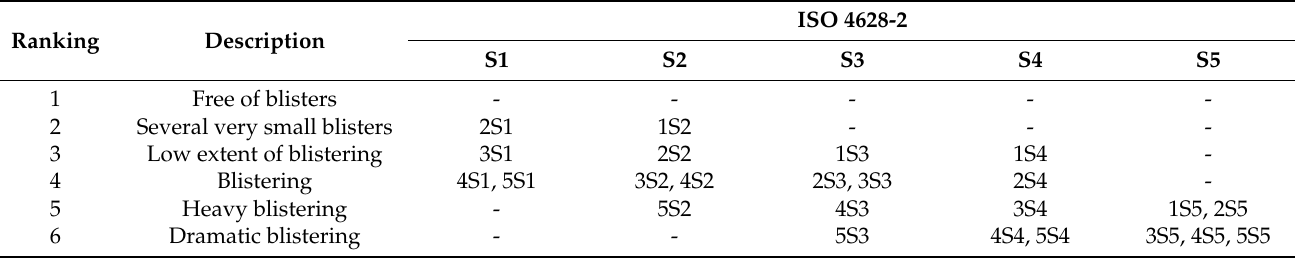
Table 1. This internal ranking enabled numerical processing of the results. Table 1. Internal ranking of blistering with approximate correlation to the ISO 4628-2 [27] rating.